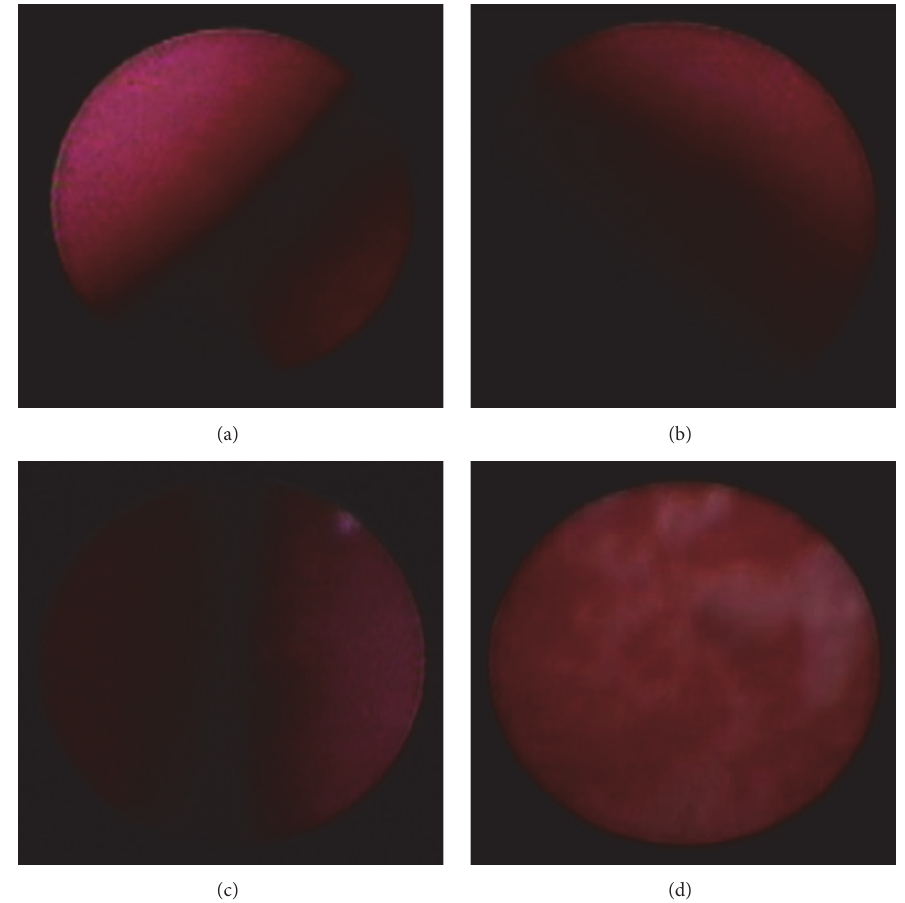
Figure 3: Images from the visual nasogastric tube insertion system (VNGS) in the manikin. (a) Turbinate. (b) Pharynx. (c) Esophageal stenosis. (d) Mucosal